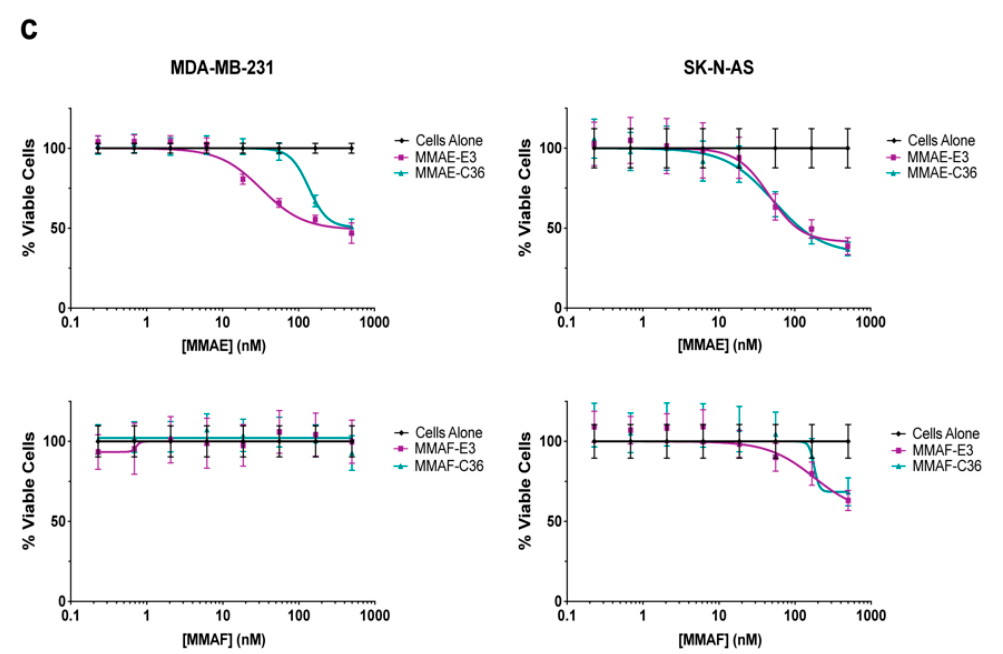
Figure 4. E3 MMAE and MMAF induce cell death in a broad number of cancer cells. ( a ) Viability of MCF7 breast, Jurkat blood and U-118MG brain cancer and PANC-1, MIA PaCa-2 and BxPC-3 pancreatic cancer cells treated with MMAF-E3 and MMAF-C36. ( b ) Viability of MCF7 breast, Jurkat blood and A431 skin cancer and PANC-1, MIA PaCa-2 and BxPC-3 pancreatic cancer cells treated with MMAF-E3 and MMAF-C36. ( c ) Viability of MDA-MB-231 breast and SK-N-AS brain cancer cells treated with MMAE-E3 and MMAE-C36 or with MMAF-E3 and MMAF-C36. The MMAE-C36 and MMAF-C36 data for the pancreatic cancer cells is from [13]. Cells were incubated with increasing concentrations of ApTDCs and viability determined at 144 h.